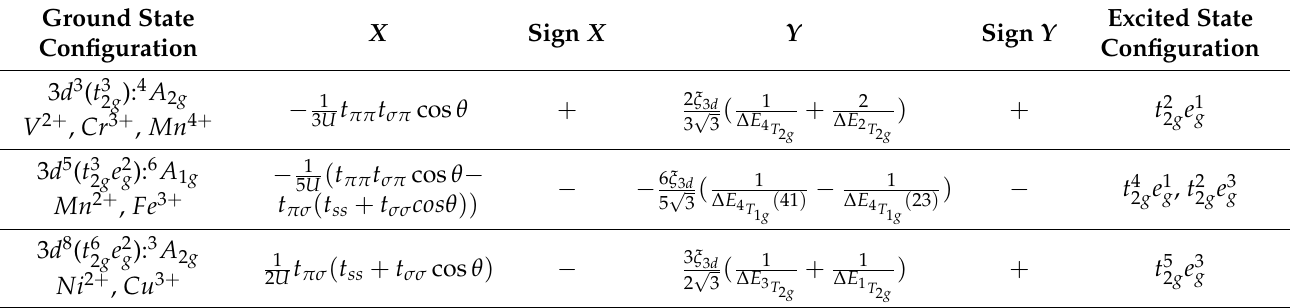
Excited State Configuration